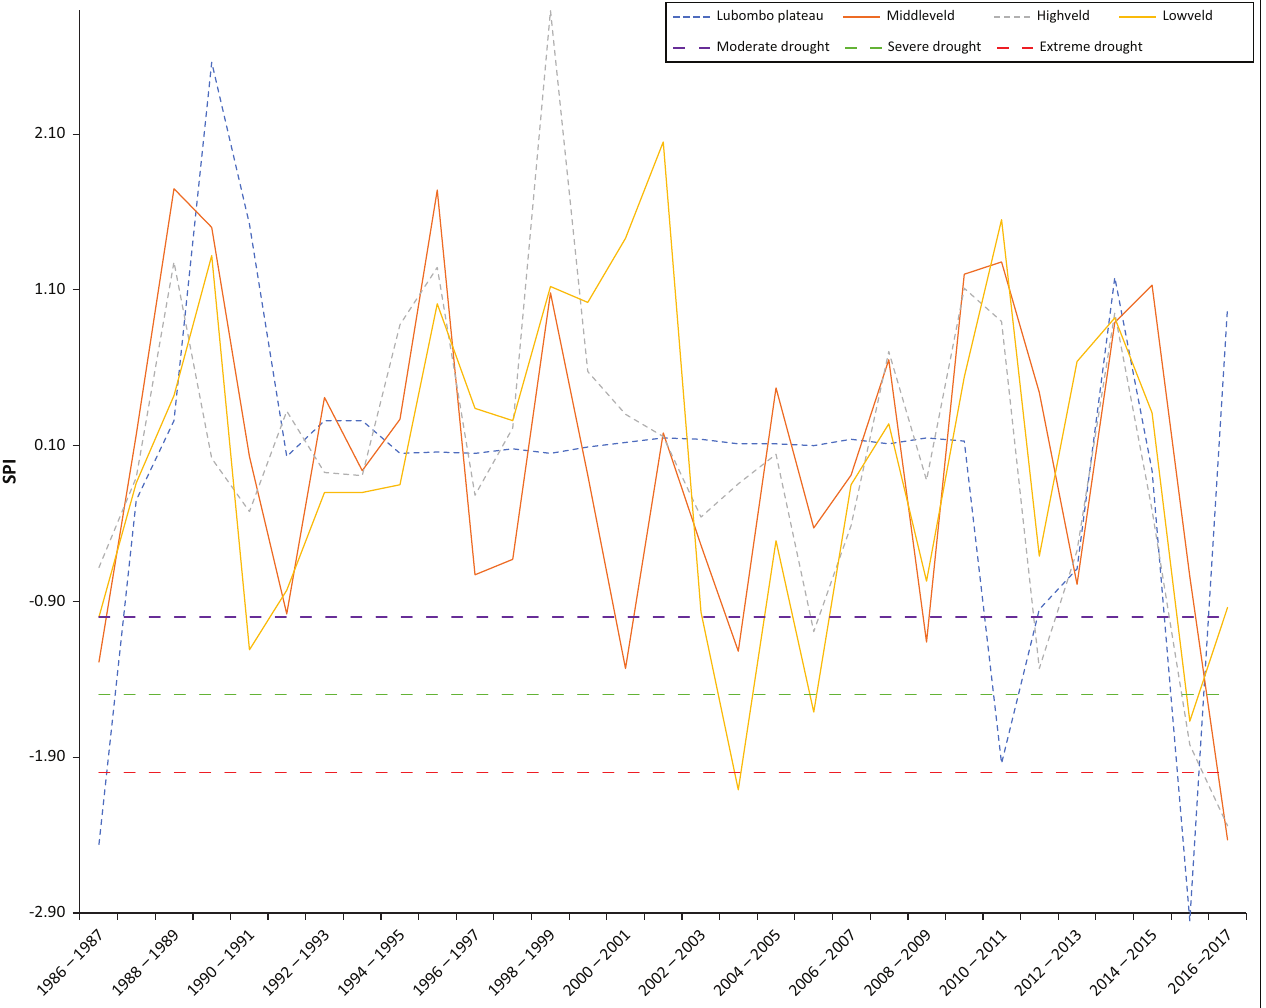
SPI, Standard Precipitation Index. FIGURE 2: Three-month Standard Precipitation Index values for the Highveld, Middleveld, Lowveld and Plateau agro-ecological zone.